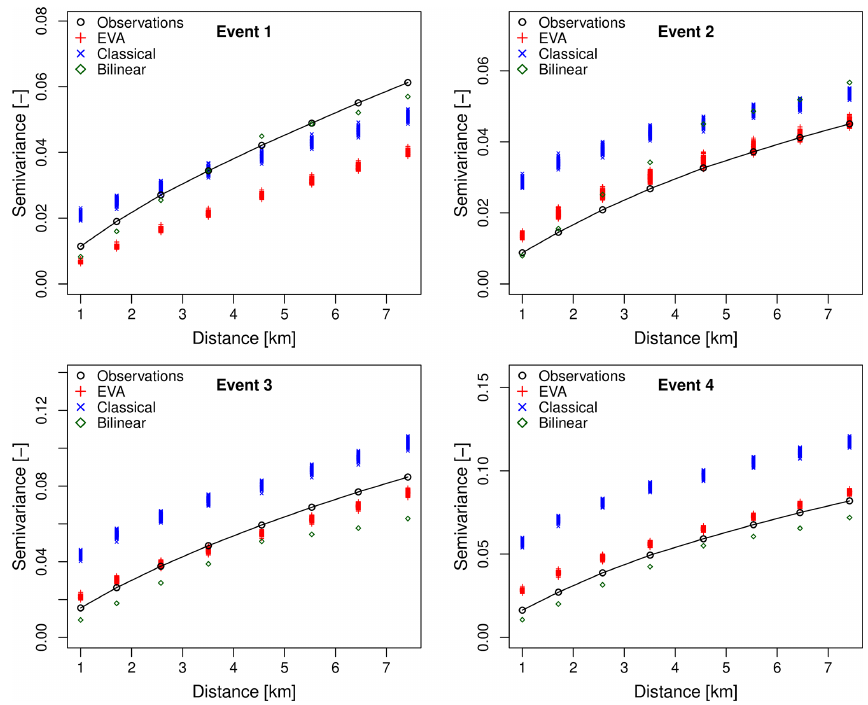
Figure 14. Sample variograms of rainfall occurrence for events 1–4 and spatial displacements up to 8km. The downscaling factor is 64 (i.e., input resolution of an 8km × 8km and target resolution of 1km × 1km). For each cascade model, 100 different realizations were generated. The generator model was estimated from the coarse-scale data at an 8km × 8km